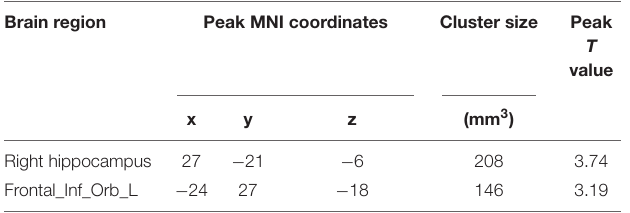
TABLE 2 | Brain regions showing significant differences in the degree centrality between postpartum depression (PPD) and healthy controls (HCs). Brain region Peak MNI coordinates Cluster size Peak T value x y z (mm 3 ) Right hippocampus 27 − 21 − 6 208 3.74 Frontal_Inf_Orb_L − 24 27 − 18 146 3.19